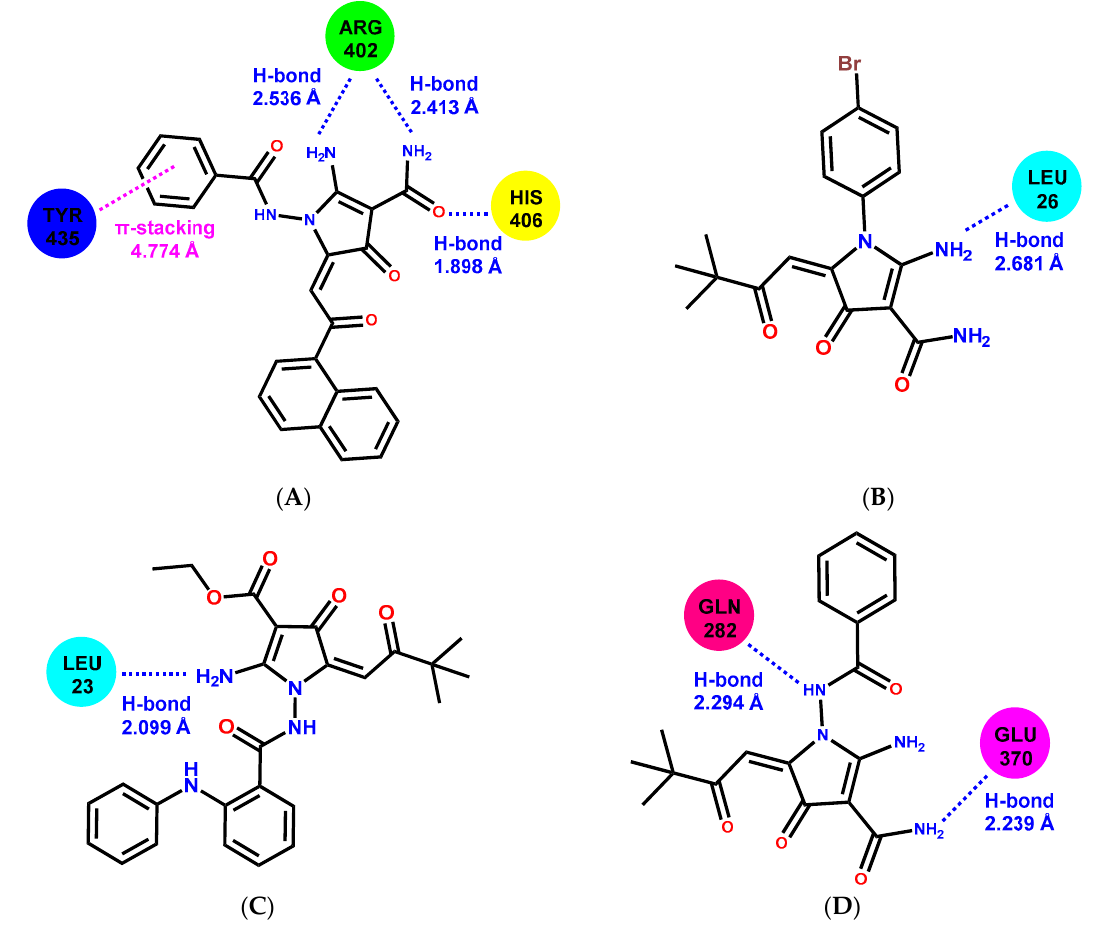
Figure 10. The molecular docking results and binding sites of 2- АРСА -I ( A , B ), 2- АРСА -II ( C , D ), 2- АРСА -III ( E , F ), and 2- АРСА -IV ( G , H ) in tubulin.